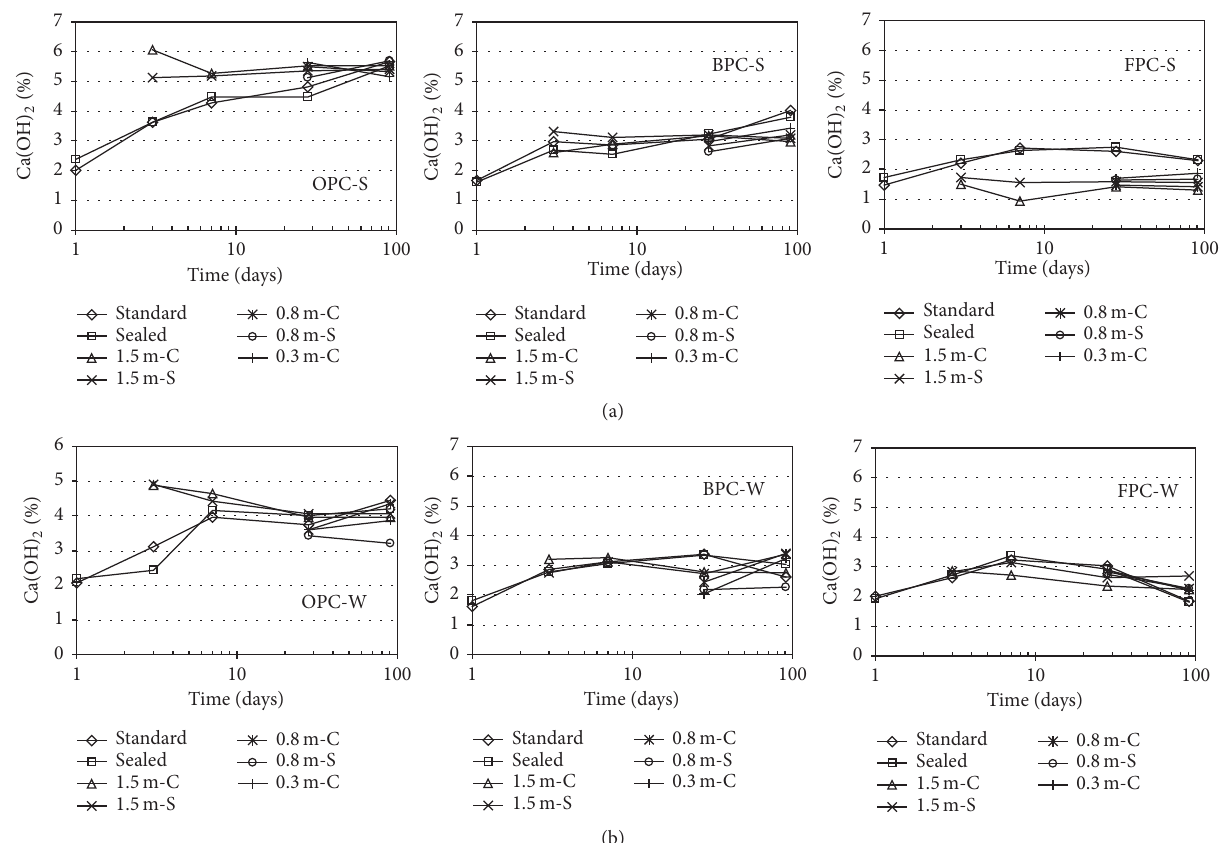
Figure 6: (a) Amount of calcium hydroxide of concrete in summer experiments. (b) Amount of calcium hydroxide of concrete in winter